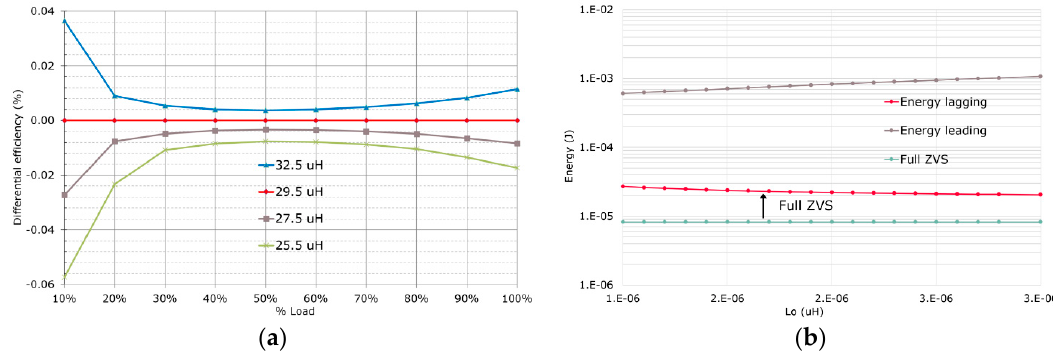
Figure 12. Available energy for the ZVS transitions depending on the value of the output inductor L o at 10% of the load. ( a ) Simplified model without clamping diodes; ( b ) with primary side clamping diodes in the lagging leg.